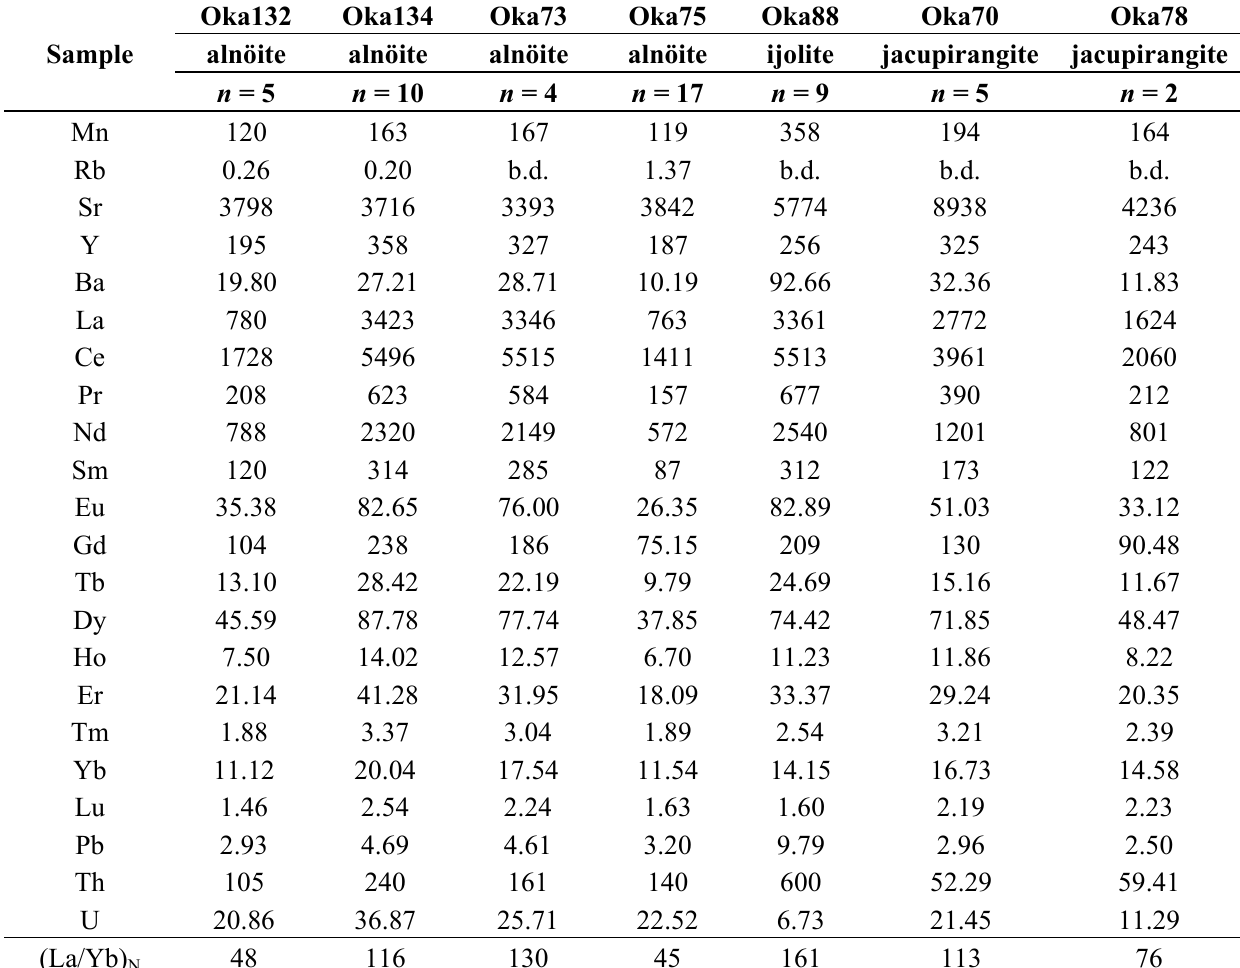
Table 5. Trace element abundances of apatite from ijolite, alnöite and